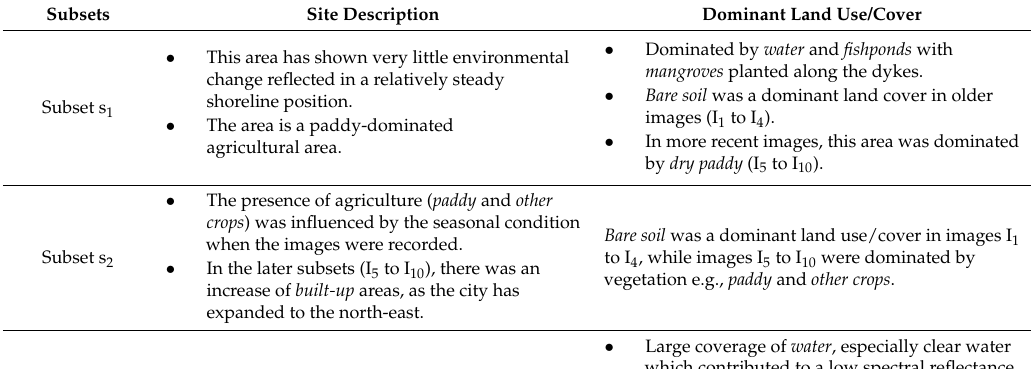
Table 2. The description of subsets used for upscaling and for testing transferability of the